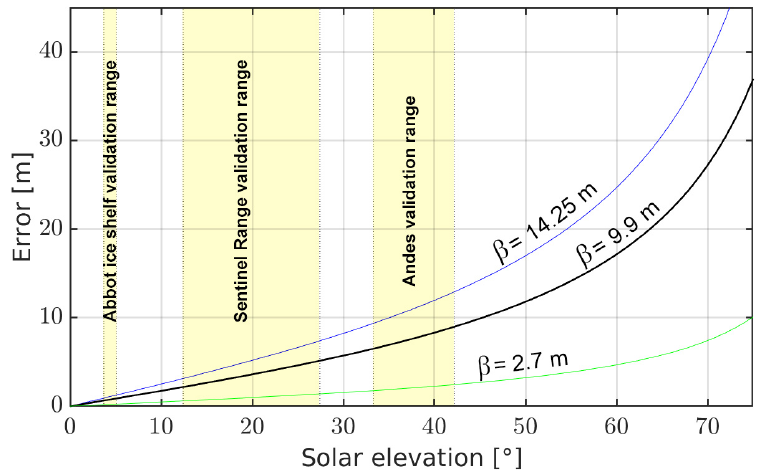
Figure 21. Magnitude of the bias error as a function of the apparent solar elevation θ for three different values of the bias constant β . Yellow shading shows the range of solar elevations used for each validation site.